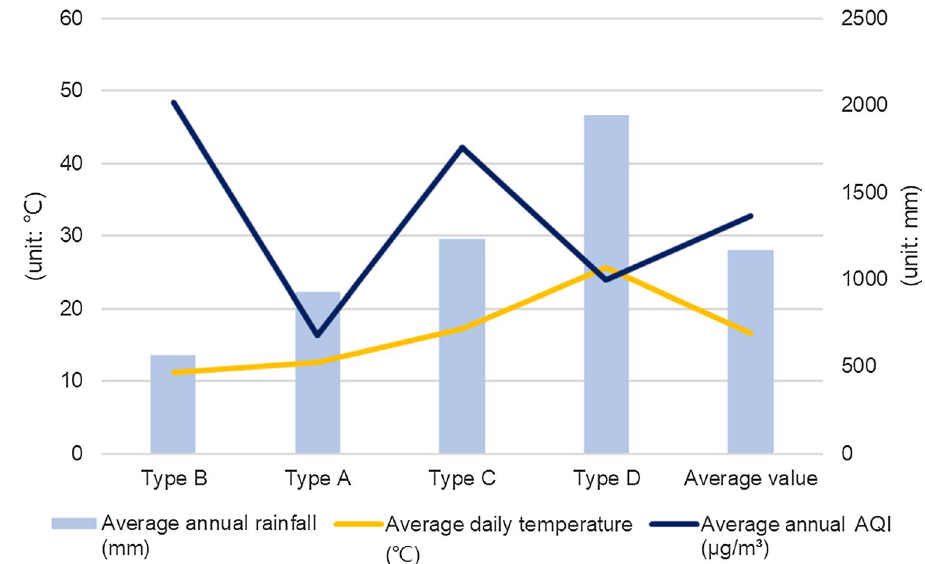
Fig. 4 Data of Type A to D